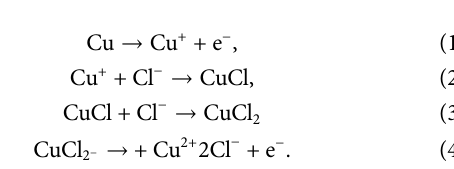
Frontiers in Materials |